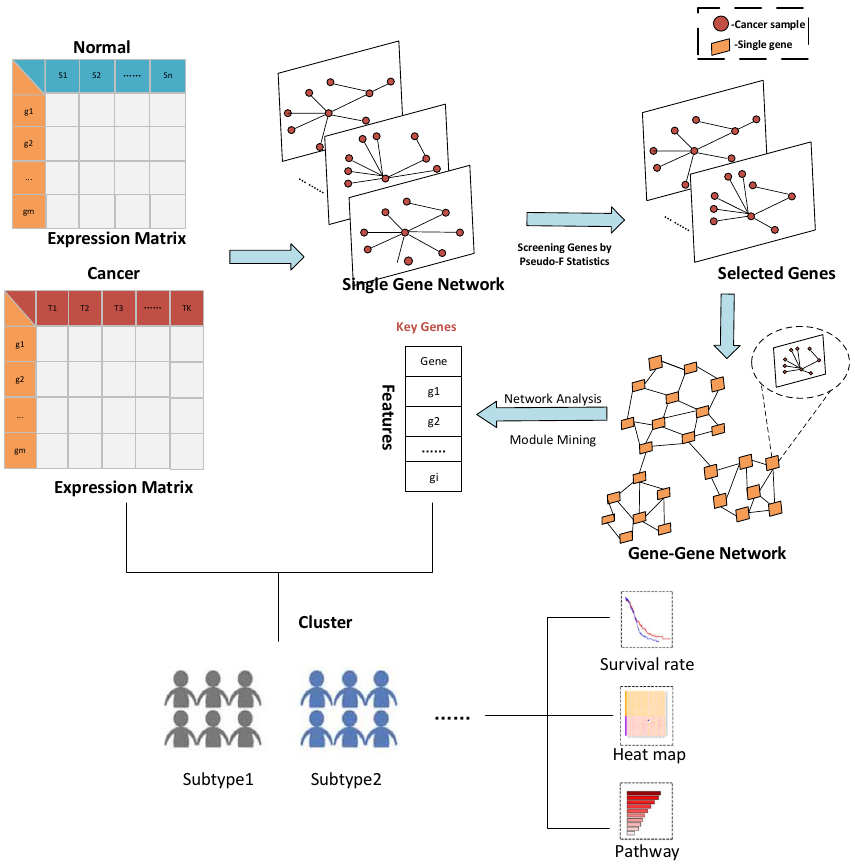
Figure 1. The overall process framework of the HSSG.